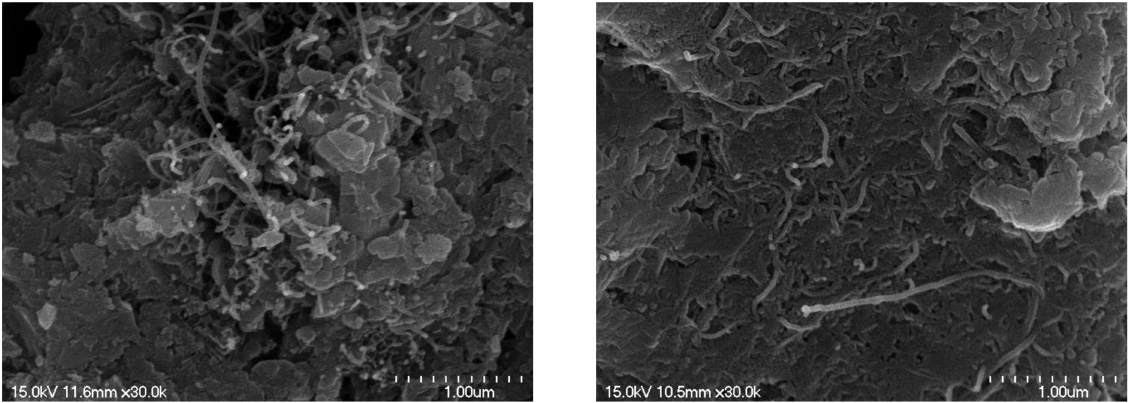
Figure 11. SEM images of